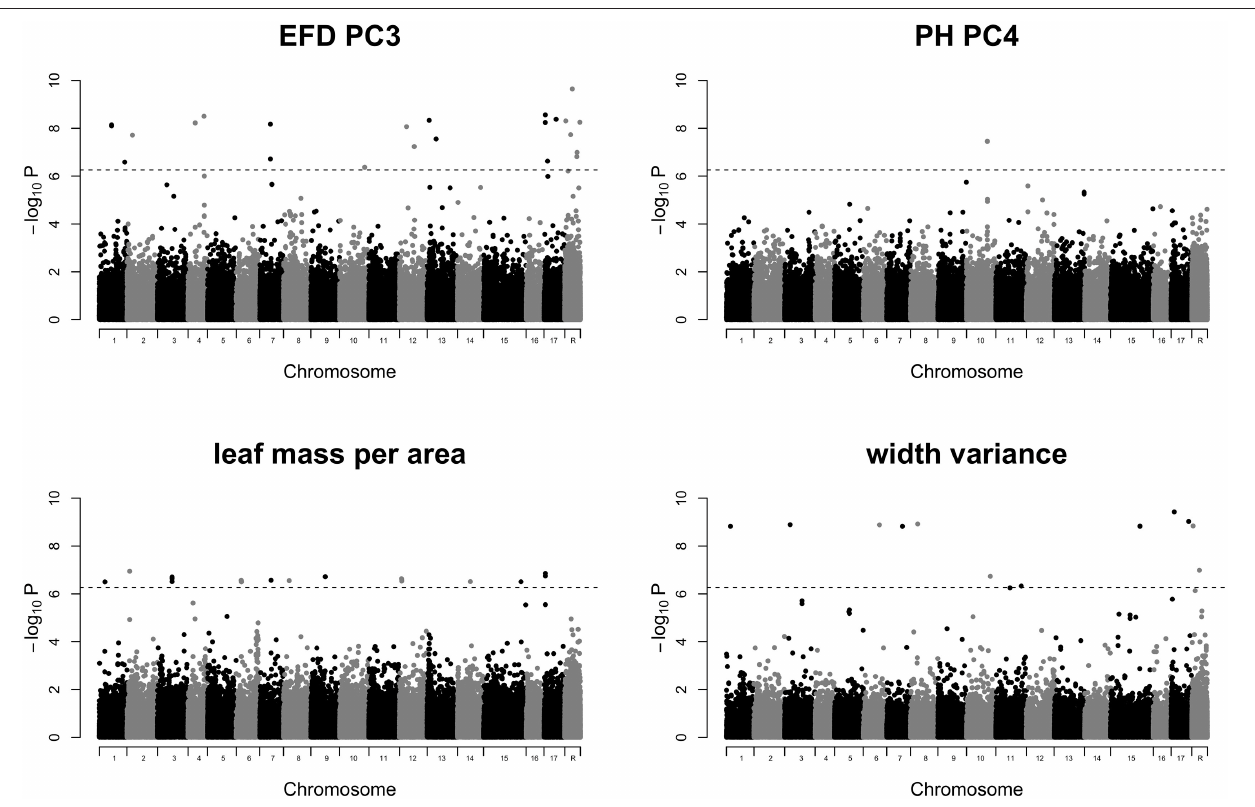
FIGURE 7 | Manhattan plots of GWAS results for traits of interest. Results are shown for EFD PC3, PH PC4, leaf mass specific area, and width variance. P -values are log-transformed. The horizontal dotted line represents the simpleM-corrected significance threshold. Chromosome R indicates SNPs found on contigs unanchored to the reference genome. All remaining Manhattan plots are included in Figure S4